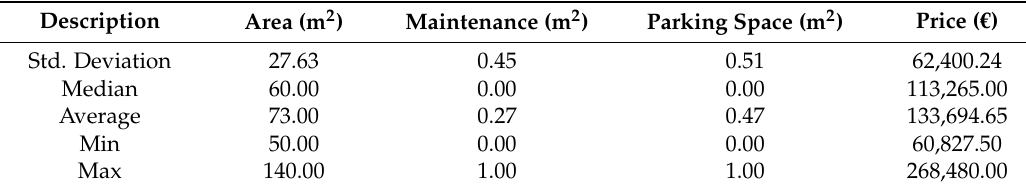
Table 2. Statistical description of the real estate